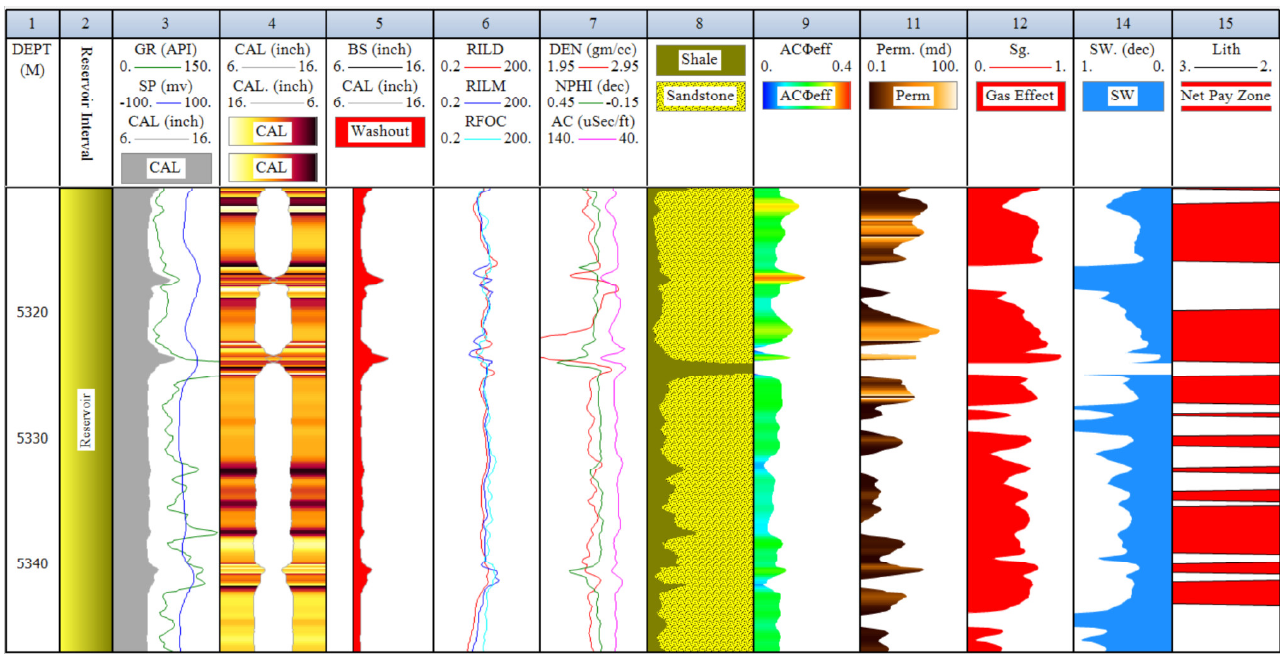
Figure 3. The conventional log overview and litho saturation cross plot of YK16 in the Yakela gas condensate field indicates that the current research Formation (zones) reveals a significant number of sub-reservoir gas zones, where the average water saturation value is 36 percent.